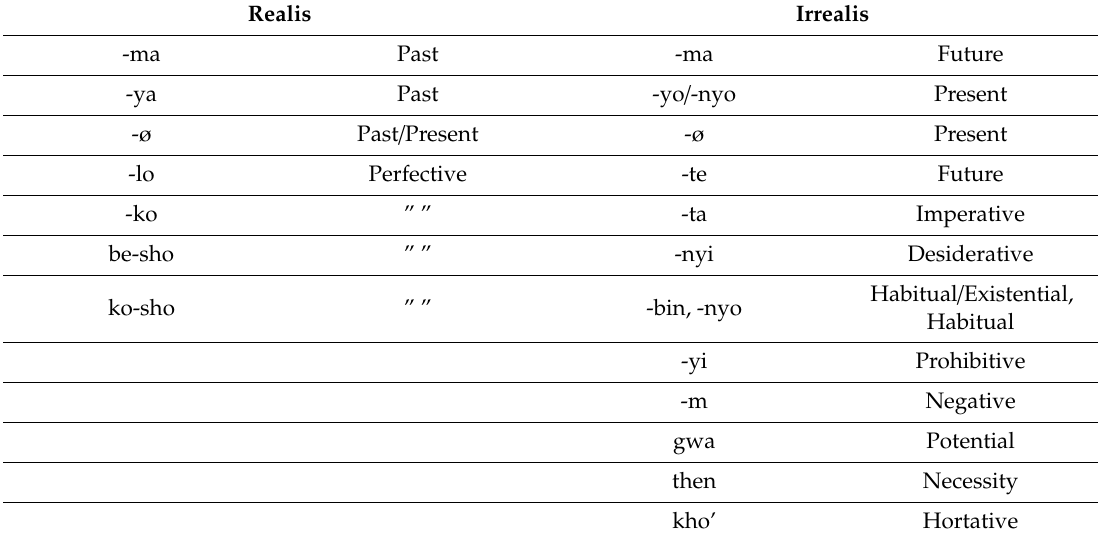
Table 3. Realis and irrealis moods in